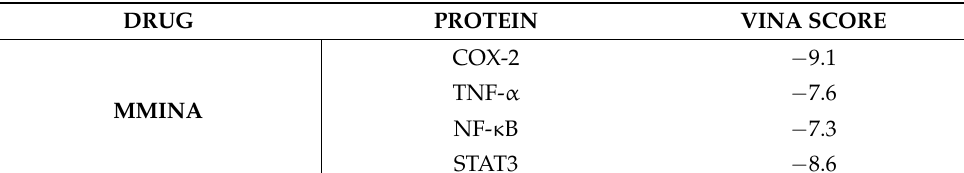
Table 3. MMINA and inflammatory pathway proteins docked complexes along with the vina score.